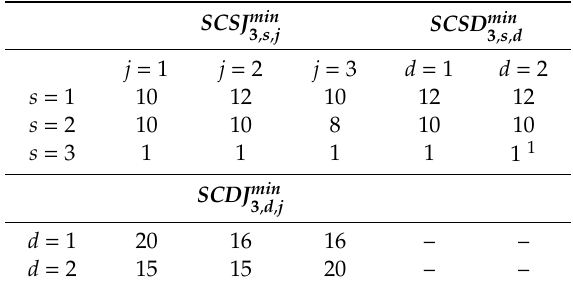
Table A22. Minimum loading capacity per shipment of product 3 (units).